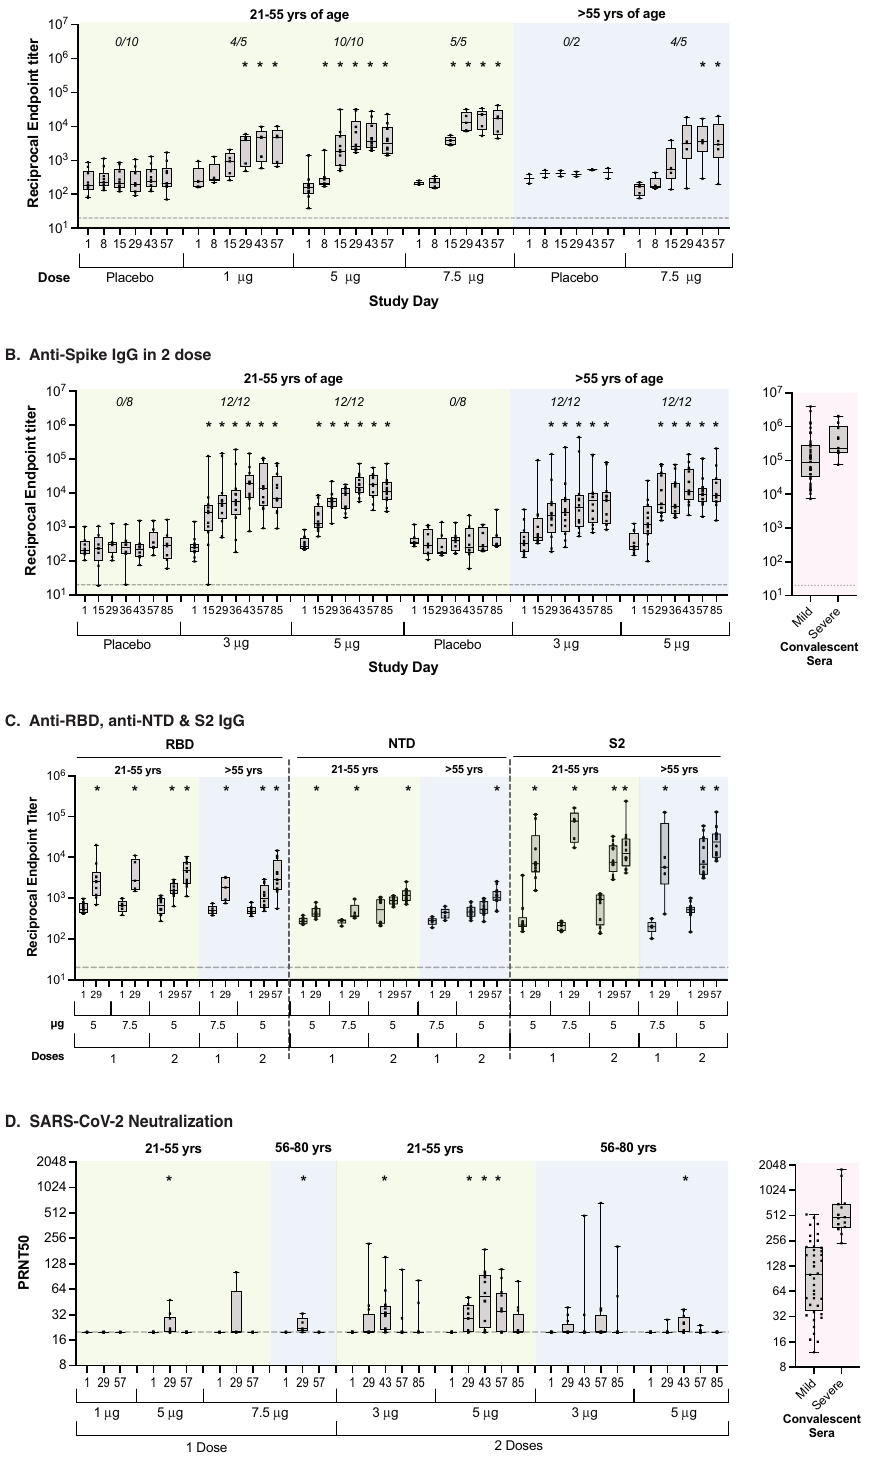
Fig. 4 SARS-CoV-2 speci fi c antibody responses. Shown are IgG reciprocal endpoint titers to SARS-CoV-2 whole ectodomain Spike using Luminex immune-Assay following 1 dose ( A ) and 2 doses ( B ) of vaccines. IgG reciprocal titers to the Spike subdomains, i.e., receptor-binding domain (RBD), N-terminal binding domain (NTD), and domain 2 (S2) using Luminex immuno-assay is represented for selected cohorts and timepoints ( C ). Antibody neutralization of live SARS-CoV-2 virus was measured using a BSL3 plaque reduction neutralization assay (PRNT) and represented as 50% neutralization titers (PRNT50) ( D ). Data are presented as boxplots with median and interquartile range (IQR). For each cohort, antibody data from each timepoint were compared to baseline (i.e., day 1) using Mann – Whitney U test (all P -values < 0.05 are marked with asterisk (*)). Each dot represents an individual participant. IgG seroconversion rates at day 29 for 1 dose cohorts and day 57 post- vaccination for 2 dose cohorts are speci fi ed on panels A and B ,